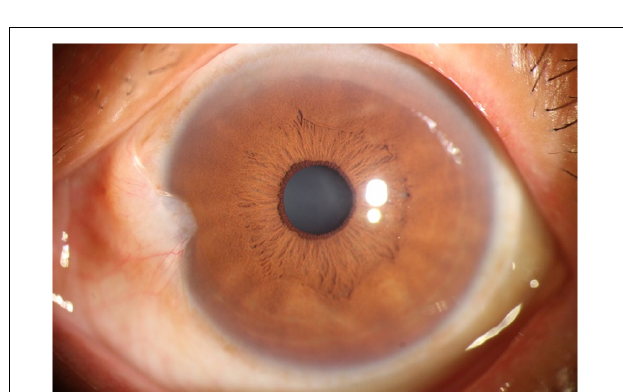
FIGURE 2 | An example of the Observation group (pterygium).